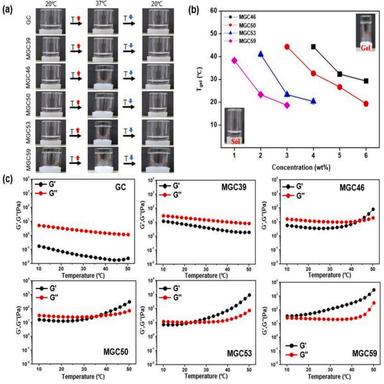
Thermo-reversible sol-gel transition of MGCs: (a) Photographs showing MGC thermogels at 20 and 37 ◦C, (b) sol-gel transition phase diagram of MGC thermogels, and (c) temperature dependent rheological behavior of MGC thermogels (PBS, pH 7.4, 4.0 wt%).